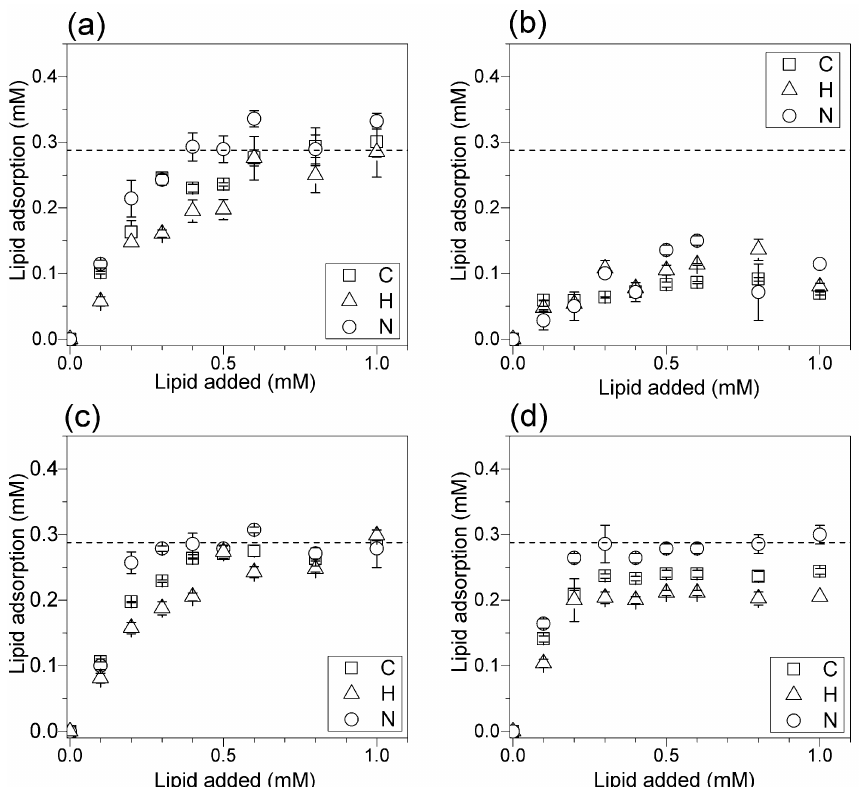
Figure 6. Adsorption isotherms for DODAB onto silica. ( a ) DODAB adsorption onto silica (2 mg/mL) from DODAB films in pure water. ( b ) DODAB adsorption on to silica (2 mg/mL) from DODAB BF in pure water. ( c ) DODAB adsorption onto silica (2 mg/mL) from films in 1 mM KCl water solution. ( d ) DODAB adsorption onto silica (2 mg/mL) from DODAB BF in 1 mM KCl aqueous solution. The dashed line at 0.288 mM DODAB represents the theoretical concentration for bilayer adsorption. Each mean adsorption value and respective mean standard deviation was obtained from at least two different determinations for each element.